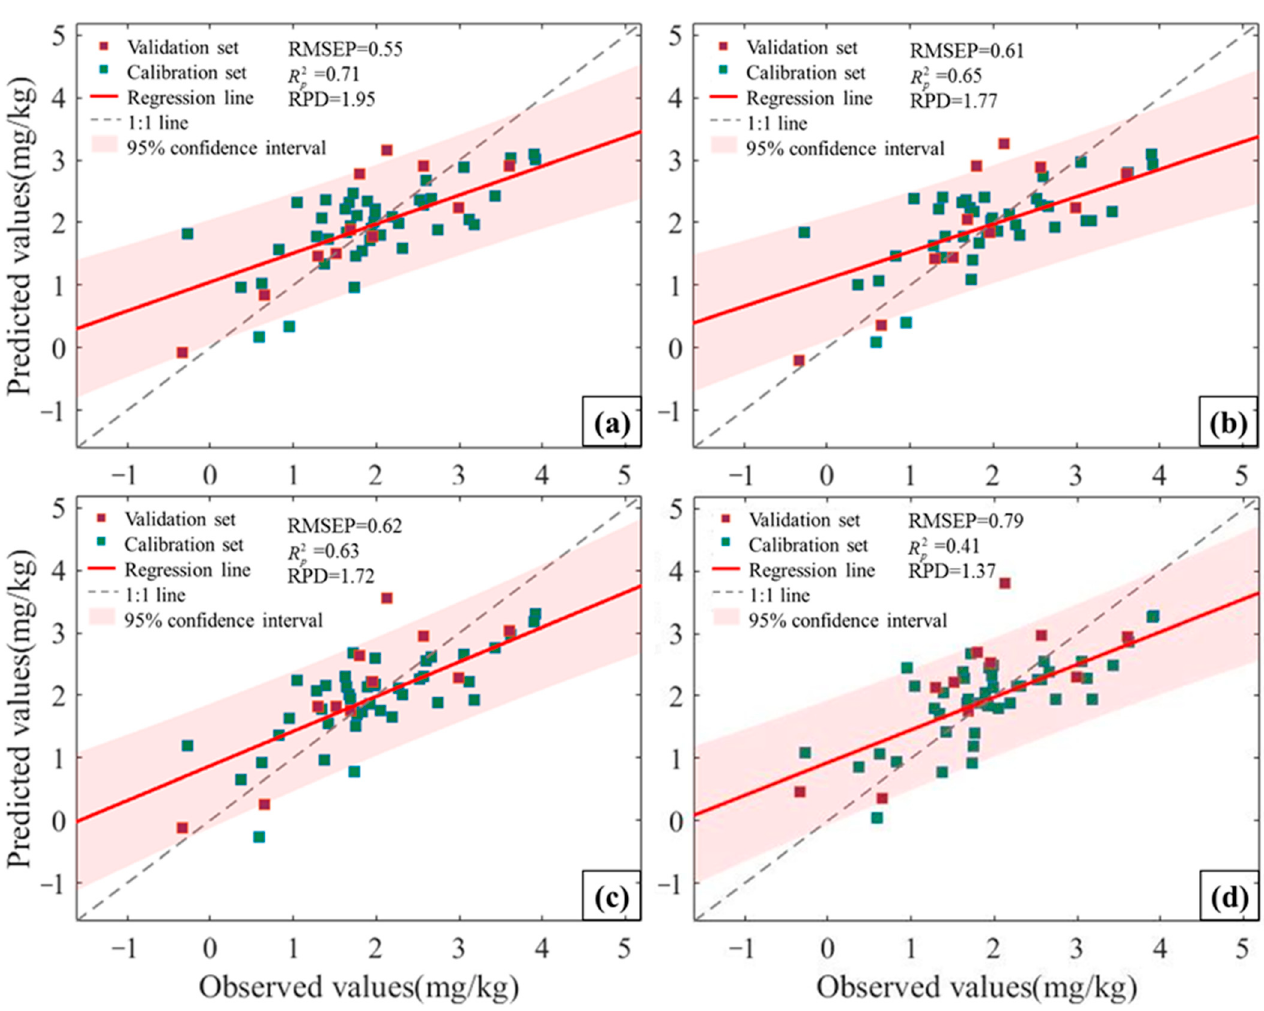
Figure 7. Scatter plots of the observed against predicted Cd concentration of Hengyang sample set: ( a ) PLS NSS-VIP-VNIR ; ( b ) CARS-PLS NSS-VIP-VNIR ; ( c ) PLS VNIR ; and ( d ) CARS-PLS VNIR (validation ratio = 1/5).